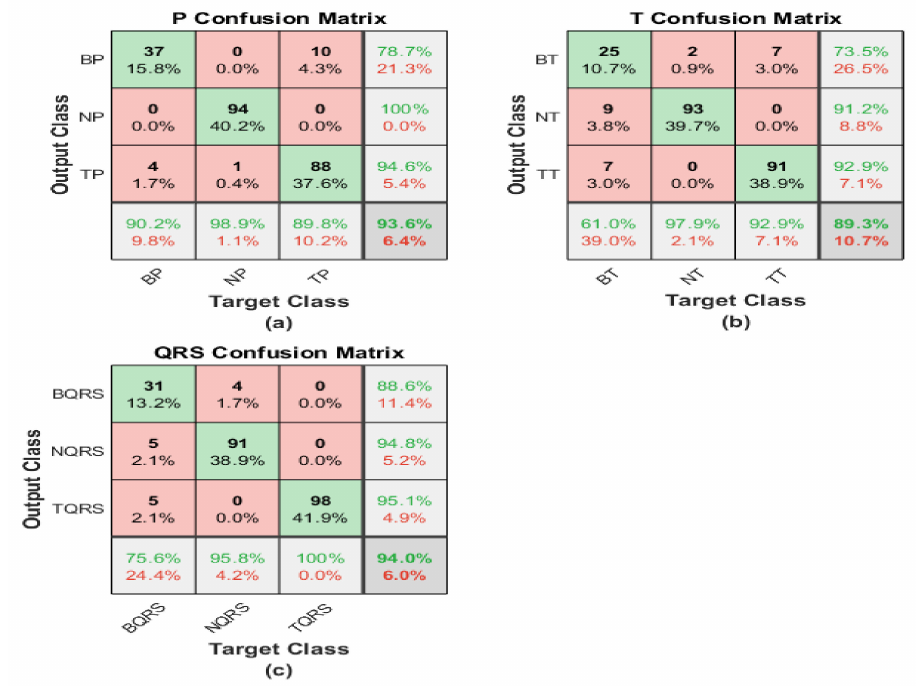
Figure 11. Confusion matrices of ECG irisgram using ShuffleNet: ( a ) P-waves irisgram; ( b ) T-waves irisgram; ( c ) QRS-waves